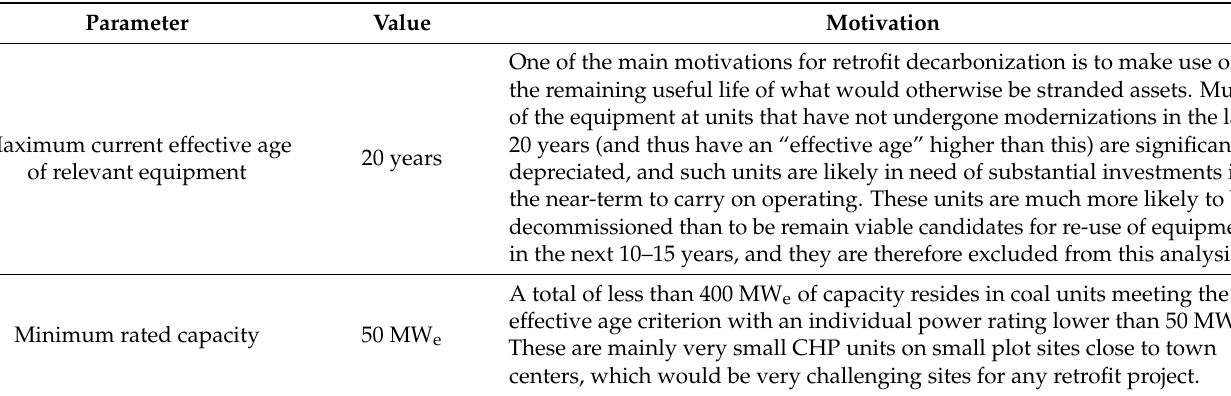
Table 2. Threshold requirements for coal unit inclusion in retrofit decarbonization analysis. Parameter Value Motivation